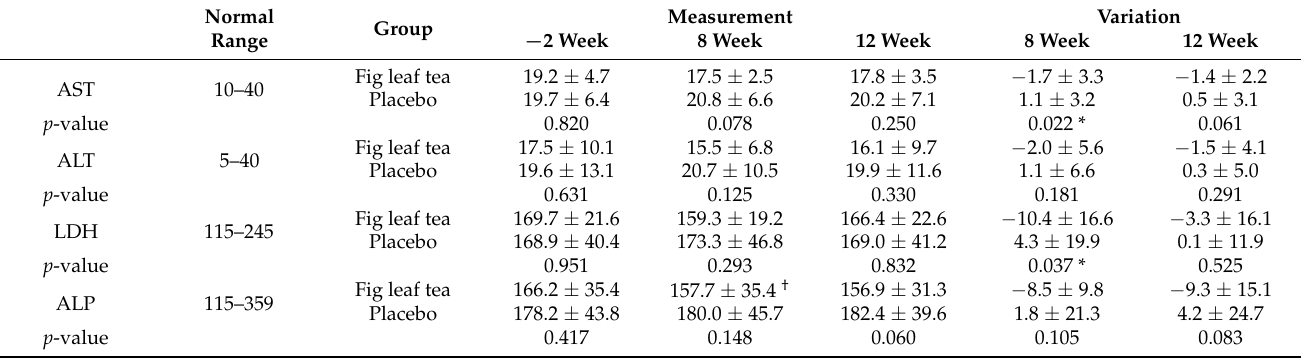
Table 7. Transition in liver enzyme levels.